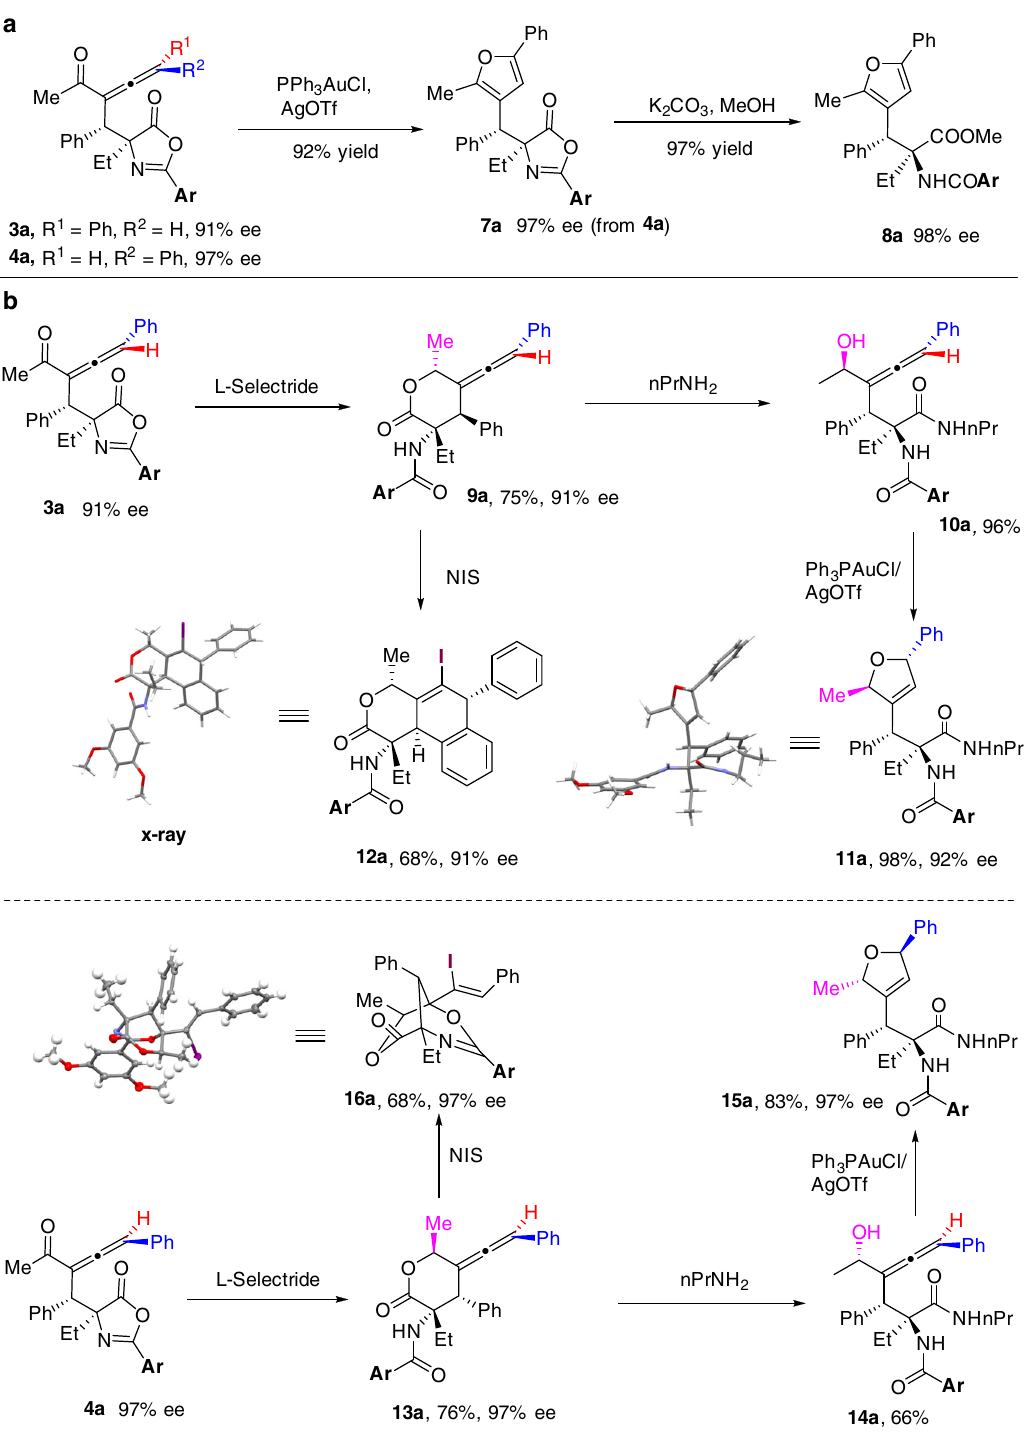
Fig. 6 Derivatizations of the chiral allene products. a Synthesis of chiral furan derivatives. b Derivatizations of the chiral allene products for chemo- diversity-oriented and stereo-diversity-oriented synthesis. Ar =